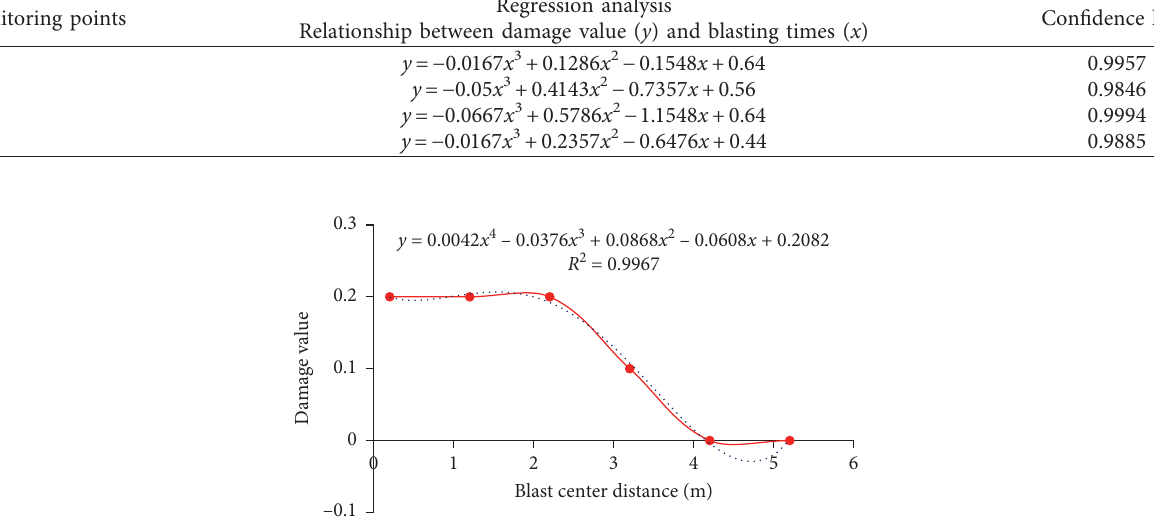
Figure 20: The variation law of cumulative damage of rock anchor beam along the axis of the powerhouse with the blast center distance (the 2 nd